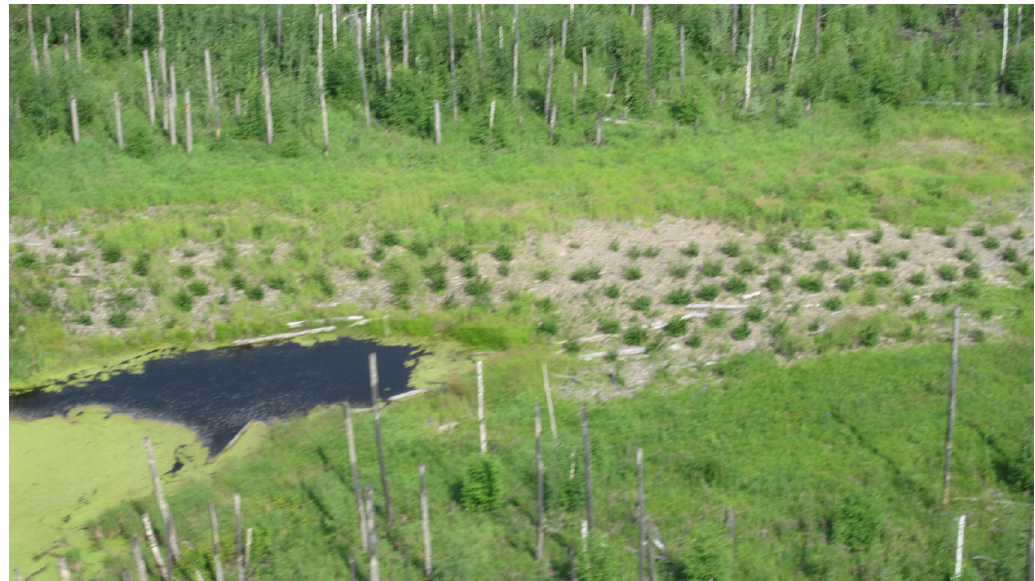
Figure 3. Alder shrub seedling planting on a pipeline ROW after 1 growing season. Photo courtesy of Enbridge Pipelines